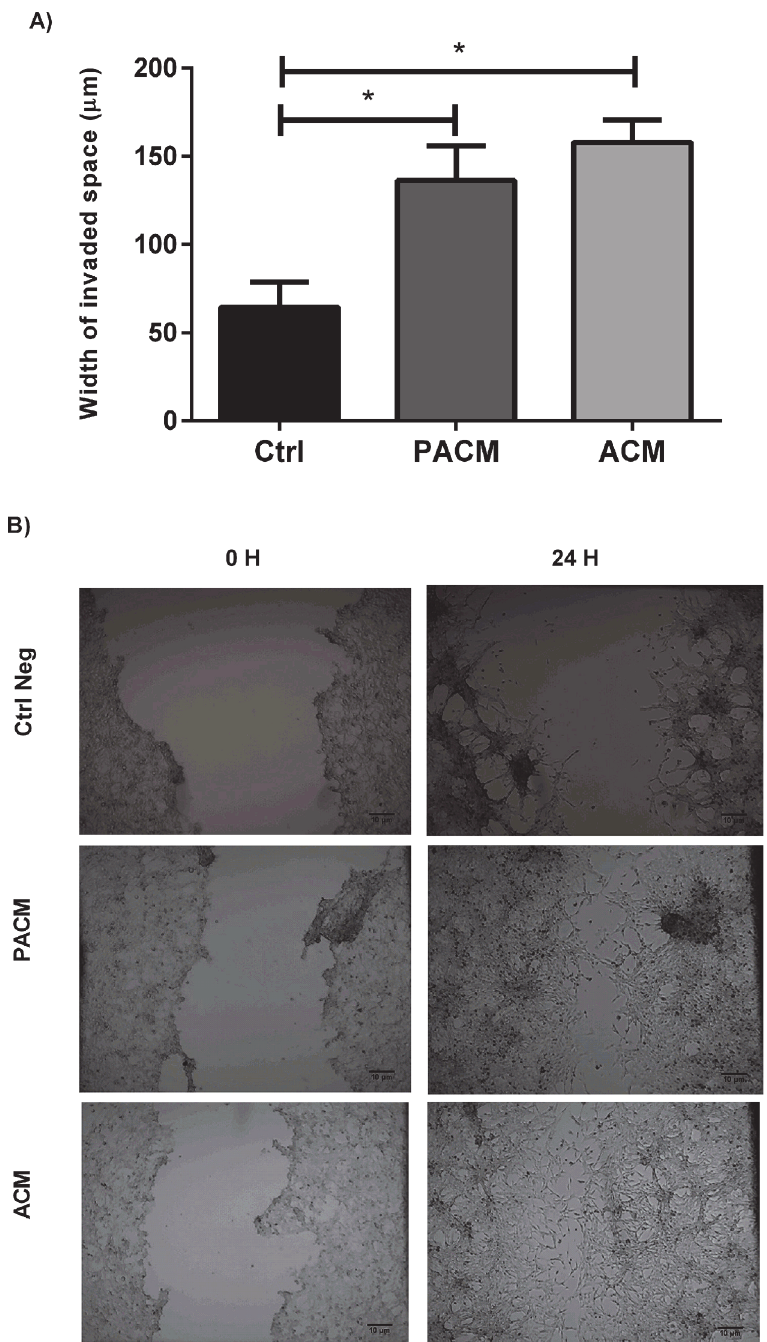
Fig 5. Migration assay. Width of invaded space by RM1 cells cultured with PACM, ACM and control media in the “ wound healing assay ” used to measure cell migration capacity ( * p < 0.05 one-way ANOVA, Newman- Keuls multiple comparison post-hoc test) (A). Photographs representative of the cellular migration in the “ wound healing ” process at the different experimental conditions measured at baseline (0H) and at 24H